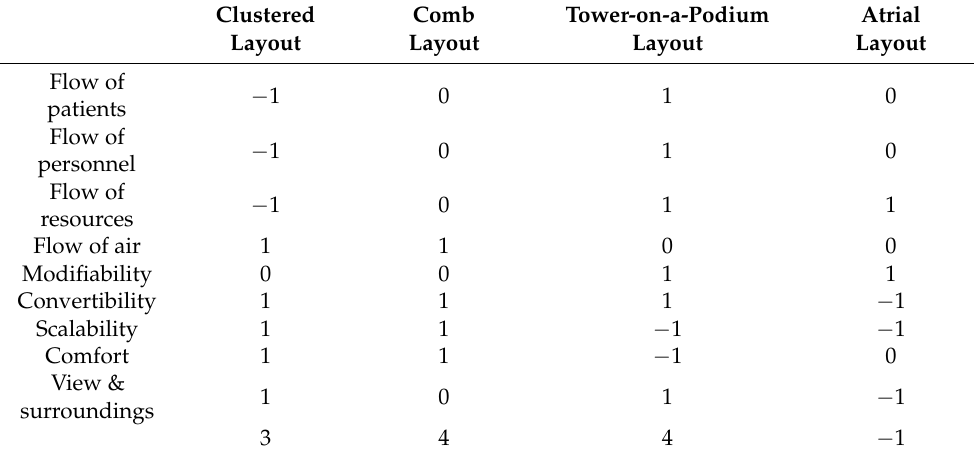
Table 1. Efficiency of different spatial layouts in everyday situation: effective (1), non-effective (0), anti-effective ( −